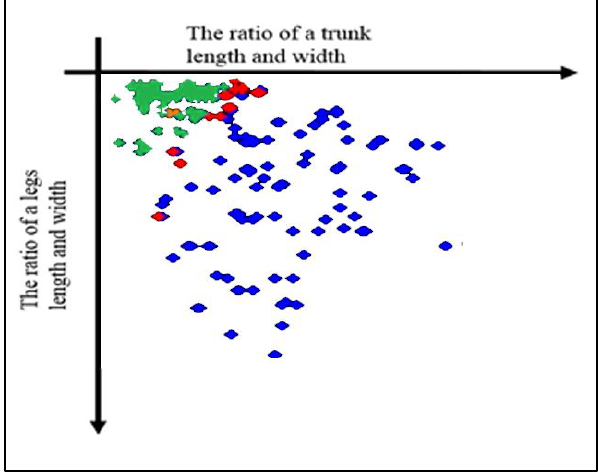
Figure 5. The contour image of the trunk region ( A ); the extracted trunk region ( B ); the contour image of the leg region ( C ); and the extracted leg region ( D ).